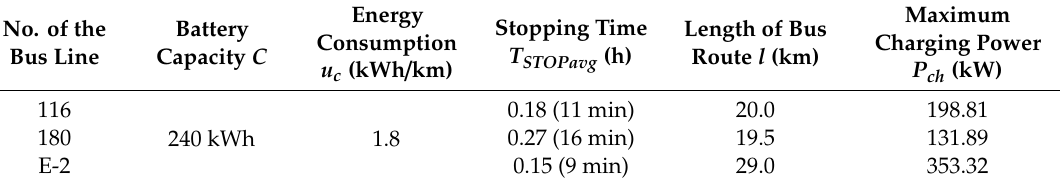
Figure 5. Hourly charging profile of electric buses at Sparta ń ska Street charging station. Table 6. Maximum power of bus charging on the Wilan ó w